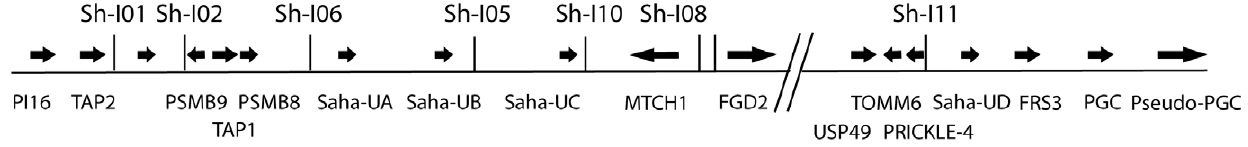
Figure 1. Location of eight MHC-linked microsatellites on devil chromosome four, associated with the MHC region. Six of these (Sh- I01, Sh-I02, Sh-I05, Sh-I06, Sh-I10 and Sh-I11) are located close to the four MHC class I loci ( Saha-UA , Saha-UB , Saha-UC and Saha-UD ) and several other genes involved in antigen presentation (TAP1, TAP2, PSMB8, PSMB9). The two remaining markers (Sh-I07, Sh-I08) are more closely linked with genes within the MHC that do not play a direct role in antigen presentation (MTCH1,